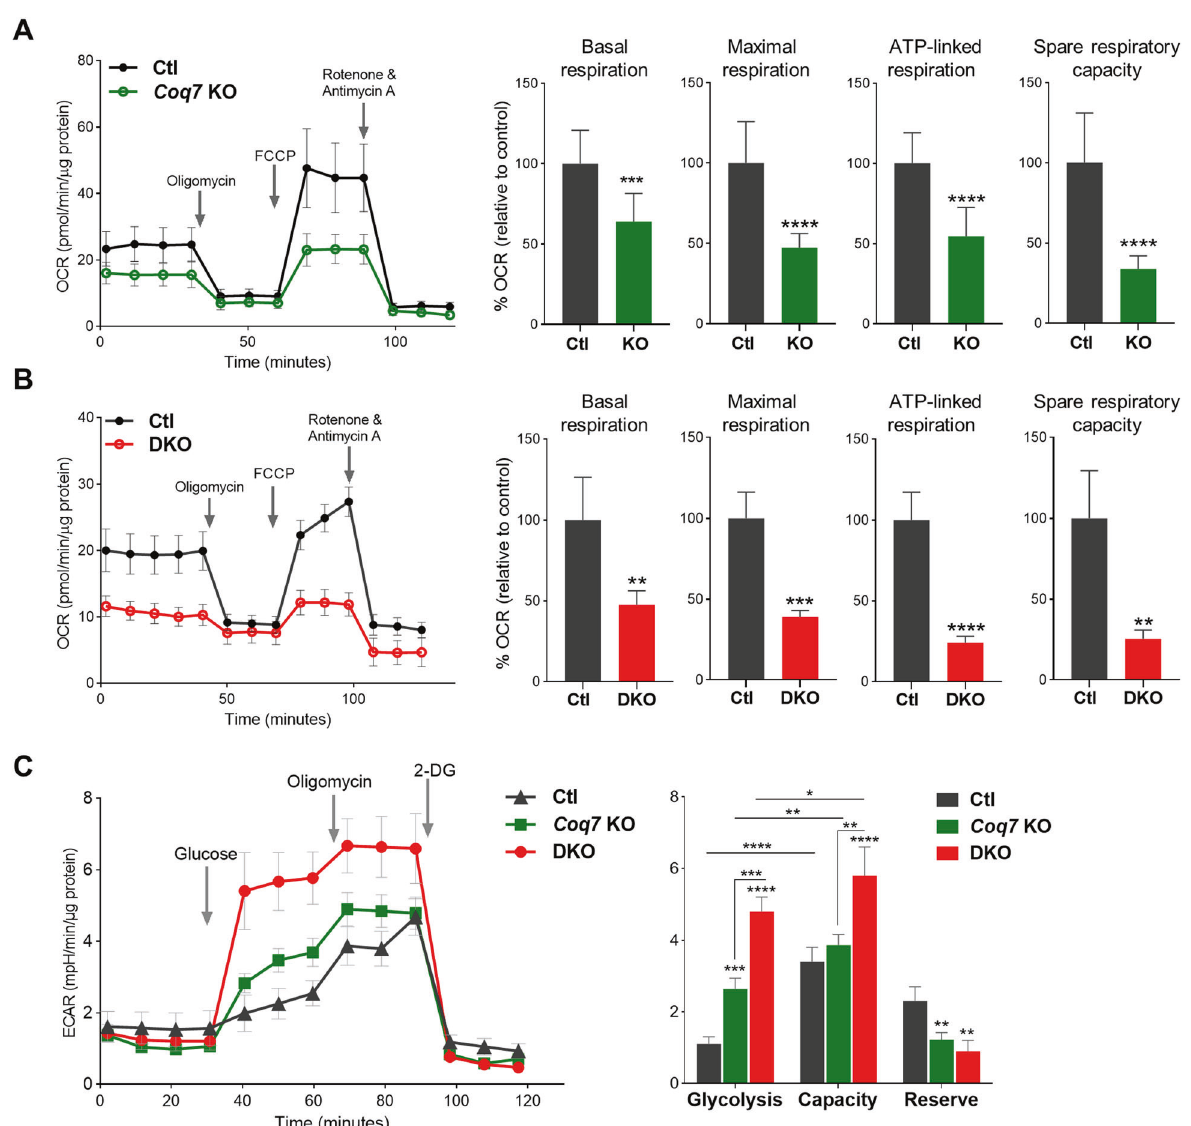
Fig. 4 A comparison of mitochondrial respiration and glycolytic activity between Coq7 KO and DKO cells. A , B Representative oxygen- consumption rate (OCR) traces are shown on the left and bar graphs show various respiratory parameters calculated using the raw traces. Values were normalized to total protein and expressed as percentage of their respective controls (Ctl) in the bar graphs. Signi fi cance was analyzed by Student ’ s t -test. C Glycolytic rate measurement. Sequential injection of glucose and oligomycin and 2-deoxyglucose (2-DG) was used to calculate glycolytic capacity and reserve. Signi fi cance was calculated by one-way ANOVA followed by Tukey ’ s post hoc test. * p < 0.05, ** p < 0.01, *** p < 0.001, and **** p < 0.0001. Error bar is SD ( n = 4 – 10). Ctl in C was Coq7 fl oxed but not recombined cells.